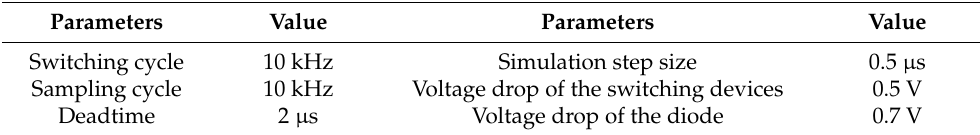
Table 2. Simulation parameters.